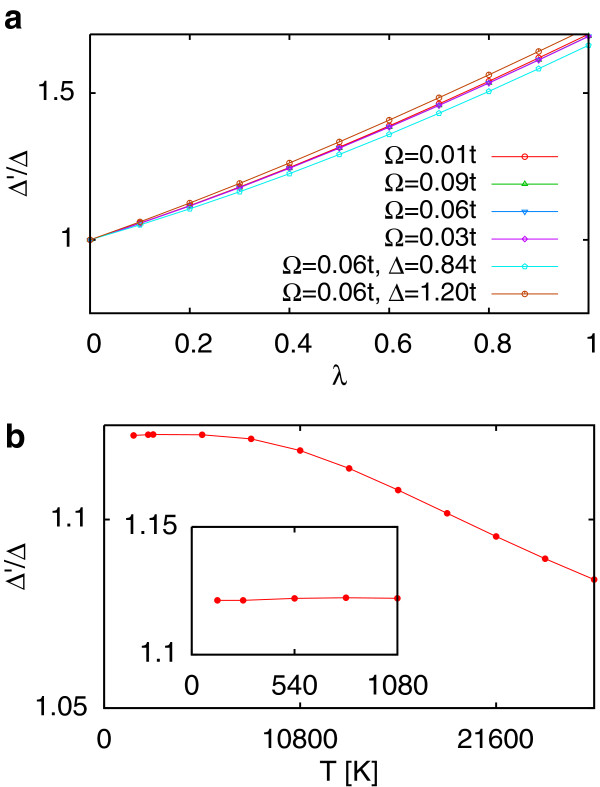
Modification of the BN bandgap.(a) The gap enhancement depends mainly on λ , is weakly dependent on Δ and shows almost no change with Ω. Calculations are made for Δ =t corresponding to a BN gap of 2Δ =4.66 eV, Δ =1.20t (2Δ =5.6 eV), and Δ =0.84t (2Δ =3.92 eV, the tight binding fit from reference [10]). t =2.33 eV, ℏΩ=0.01t=23 meV, ℏΩ=0.03t=70 meV, ℏΩ=0.06t=140 meV, ℏΩ=0.09t=210 meV, covering the full range of phonon frequencies in reference [13].
k B T =0.01t (T =268K) and λ ≤1. (b) Variation of the gap with temperature, ℏΩ=0.05t=117 meV and λ =0.2. There is a weak temperature dependence due to the large Δ, consistent with the measurements in reference [15], with gap starting to close only for extremely high temperatures T >8,000 K , presumably above the melting point of the material. Red circles show the size of the gap, red lines are a guide to the eye.